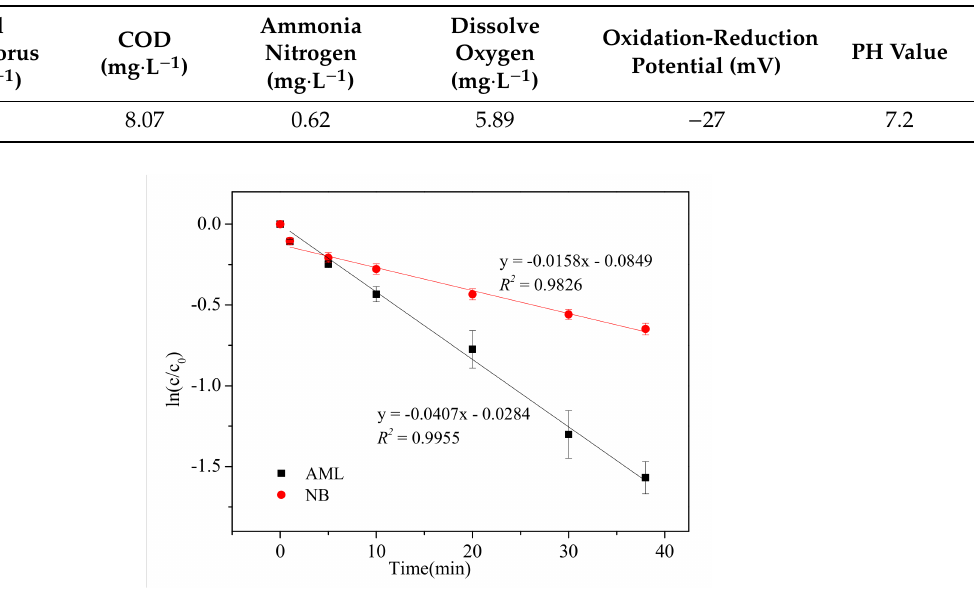
Figure A1. AML and NB degradation in the UV / H 2 O 2 process ([AML] 0 = [NB] 0 = 10 µ M, [H 2 O 2 ] 0 = 30 µ M, UV intensity = 500 µ W · cm − 2 , pH =